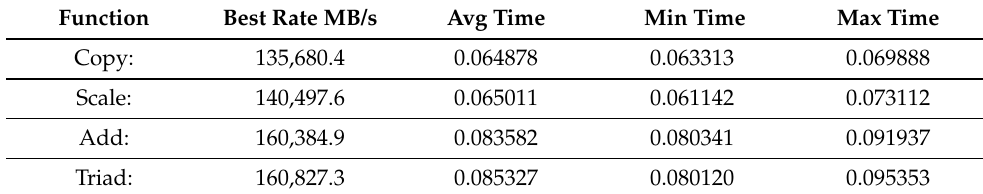
Table 5. Streaming results with OMP NUM THREADS =